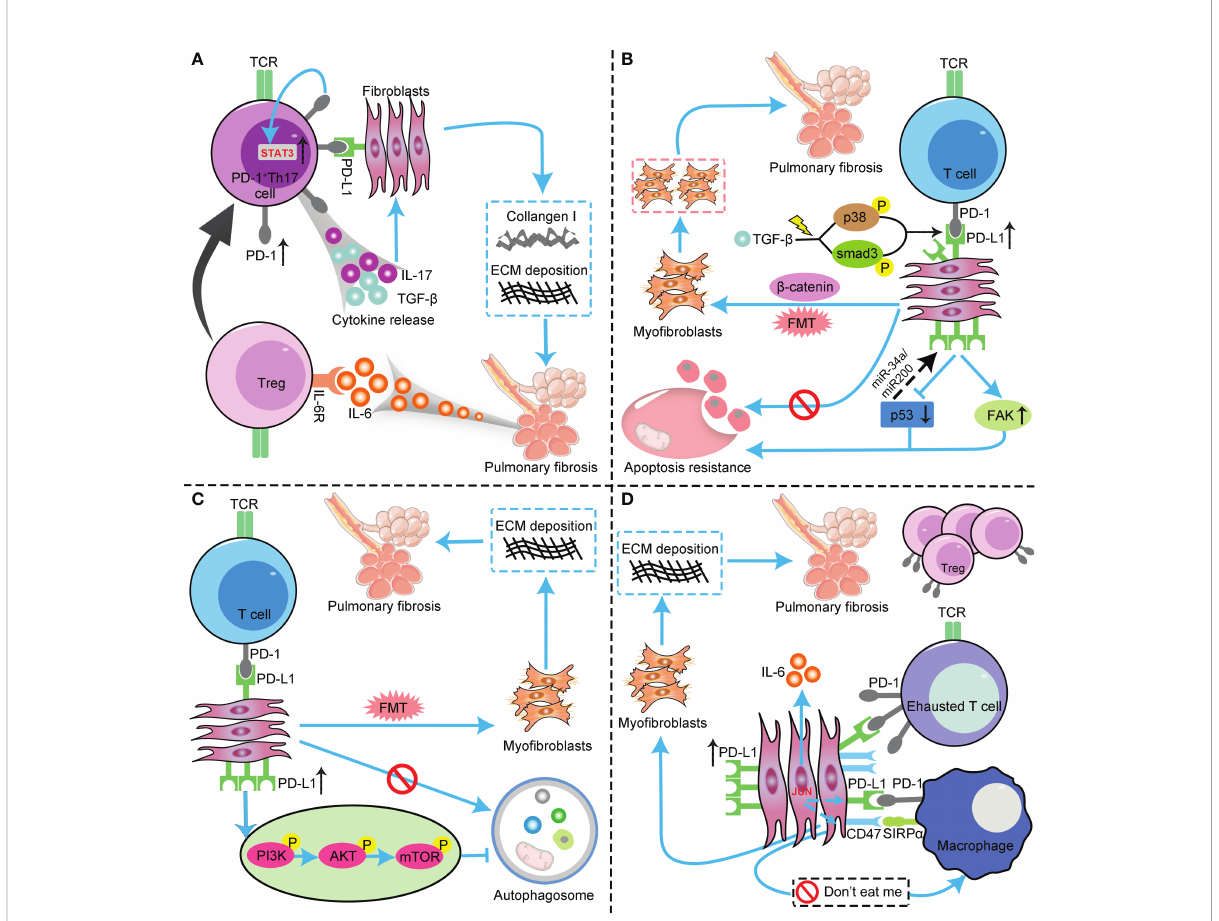
FIGURE 1 The pro fi brotic role of the PD-1/PD-L1 axis in IPF through interaction with multiple cell types and pathways. (A) PD-L1 up-regulation on Th17 T cells promotes pulmonary fi brosis through STAT3-mediated IL-17 and TGF- b production; (B) PD-L1 up-regulation on lung fi broblasts promotes pulmonary fi brosis via p53, FAK, Smad3, and b − catenin signaling pathways. On the one hand, PD-L1 up-regulation on lung fi broblasts may cause myo fi broblasts to apoptosis-resistance and evasion phagocytosis via macrophages by inhibiting the p53 pathway and activating the FAK pathway, ultimately leading to excessive proliferation of myo fi broblasts to trigger IPF. On the other hand, PD − L1 mediates lung fi broblast to myo fi broblast transition (FMT) through Smad3 and b − catenin signaling pathways, thus promoting pulmonary fi brosis; (C) PD-L1 up-regulation on lung fi broblasts could induce myo fi broblasts proliferation and ECM deposition through inhibiting autophagy, and eventually promotes pulmonary fi brosis; (D) PD-L1 up-regulation on lung fi broblasts promotes pulmonary fi brosis by inhibiting adaptive immunity. JUN upregulates the expression levels of PD-L1 and CD47 in fi broblasts and dormant macrophages. As a result, the above cells are converted into exhausted T cells and quiescent macrophages. In this context, myo fi broblasts can evade immune clearance and resist macrophage-induced phagocytosis. In addition, JUN can also directly regulate IL-6 at the chromatin level, leading to inhibitory adaptive immune responses — primarily T cell exhaustion and upregulation of activated Tregs. PD-1, programmed cell death 1; PD-L1, programmed death-ligand 1; IPF, idiopathic pulmonary fi brosis; Th17, T helper 17; STAT3, signal transducer and activator of transcription 3; IL-17, interleukin-17; TGF- b , transforming growth factor – b ; FAK, focal adhesion kinase; ECM, extracellular matrix; Tregs, regulatory T cells ; TCR, T cell receptor; FMT, fi broblast to myo fi broblast transition; AKT, protein kinase B; PI3K, phosphoinositide 3-kinase; mTOR, mammalian target of